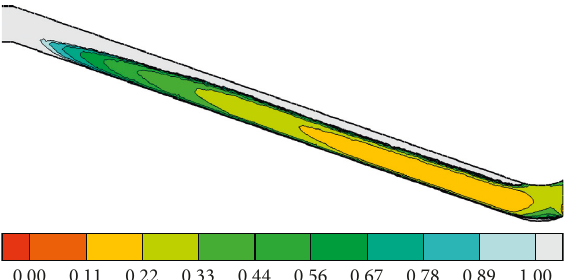
Figure 13: Cavitation number distribution in the central plane.